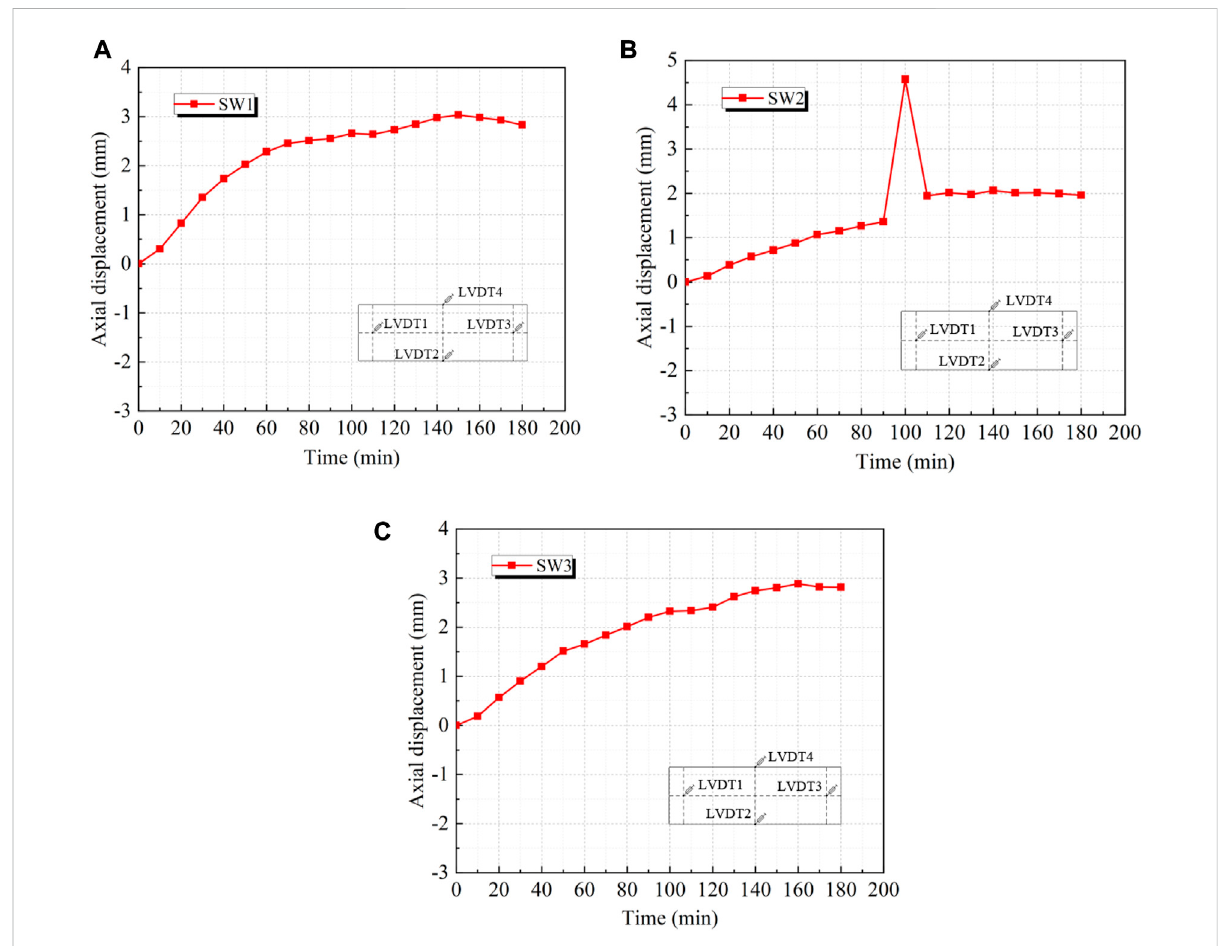
FIGURE 13 Vertical deformation-time curves of (A) SW1; (B) SW2; (C)